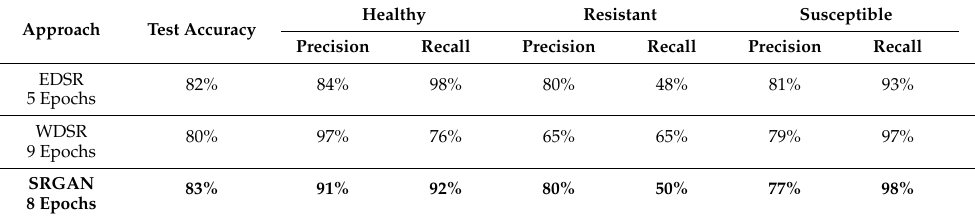
Table 3. Best results obtained using different super resolution approaches.